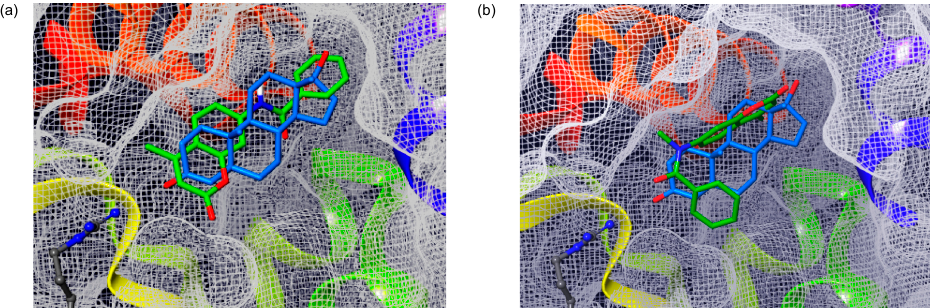
Figure 6. Docking study of coumarin derivatives ( a ) 7a and ( b ) 7b with the AR ligand-binding domain (LBD) (PDB ID: 2AMA) using AutoDock 4.2, superposed with the structure of DHT ( 1b ) in the crystal. The CPK colored residue is Arg752. Coumarin derivatives and DHT ( 1b ) are shown in green and blue, respectively.